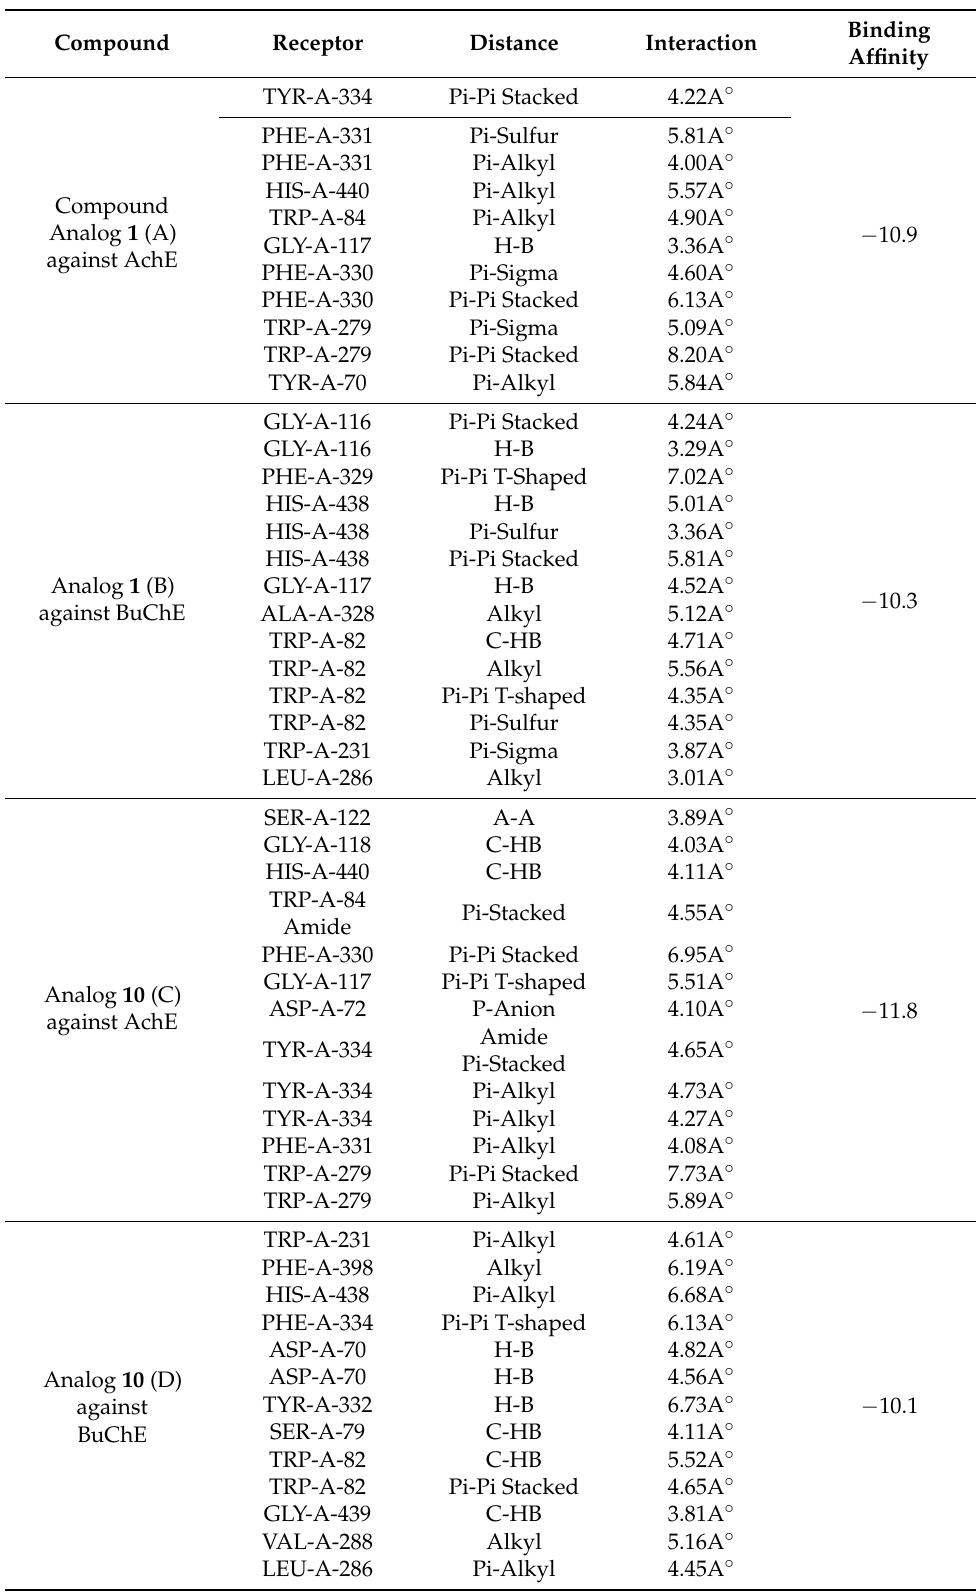
Table 2. Protein–ligand interaction profile for most potent compounds ( 1 and 10 ) and standard